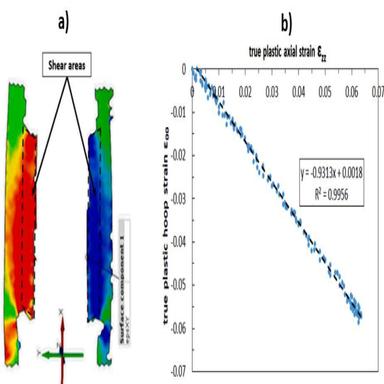
(a) Shear areas captured with DIC long the double gauge zone of the RHPST; (b) strain ratio (εx/εy)= − 0.9313 of shear stress state in the center of the gauge zone.